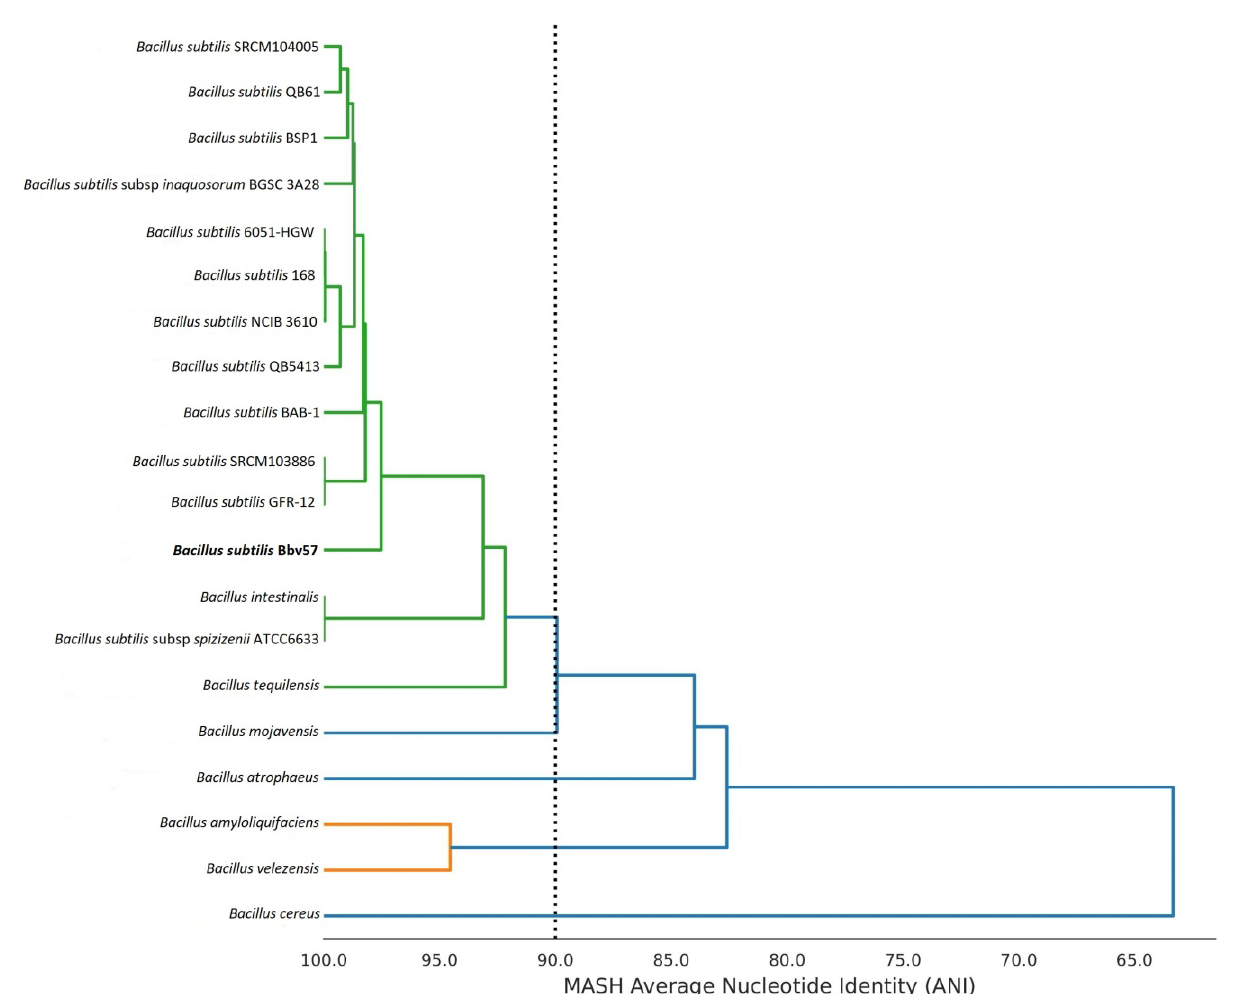
Figure 2. Average nucleotide identity-based phylogenetic tree of 20 different Bacillus strains con- structed by MASH clustering.